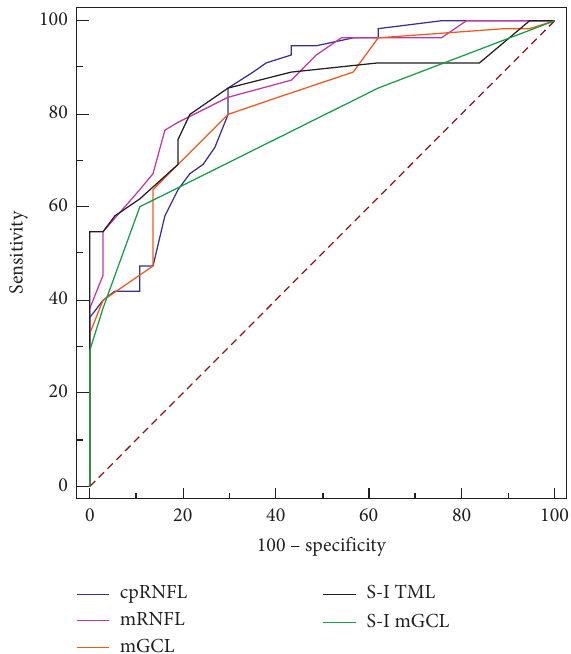
Figure 3: AROC curves for the thickness of cpRNFL, mRNFL, mGCL, and thickness differences of S-I TML, and S-I mGCL for discriminating highly myopic normal-tension glaucoma from highly myopic control subjects. AROC: areas under the receiver operating characteristic. cpRNFL: circumpapillary retinal nerve fiber layer thickness. mRNFL: macular retinal nerve fiber layer thickness. mGCL: macular ganglion cell layer thickness. S-I TML: thickness difference of total macular layer between superior and inferior hemispheres. S-I mGCL: thickness difference of macular ganglion cell layer between superior and inferior